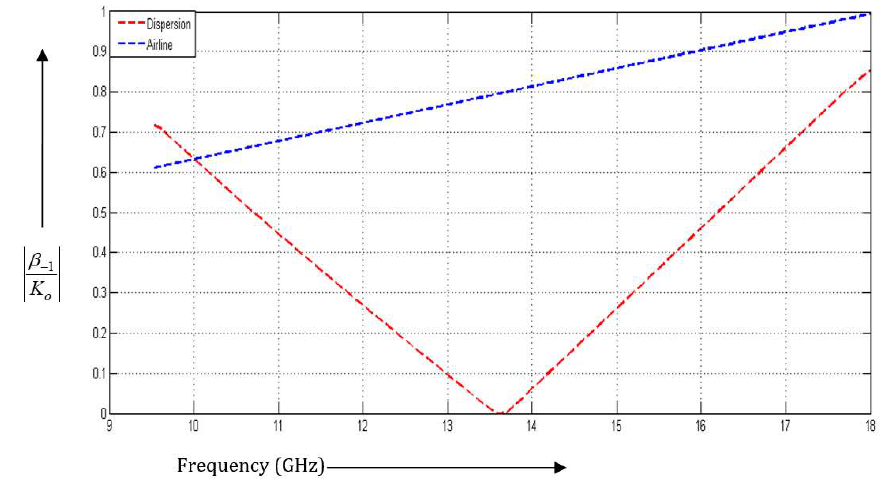
Figure 2. Dispersion diagram for unit cell.